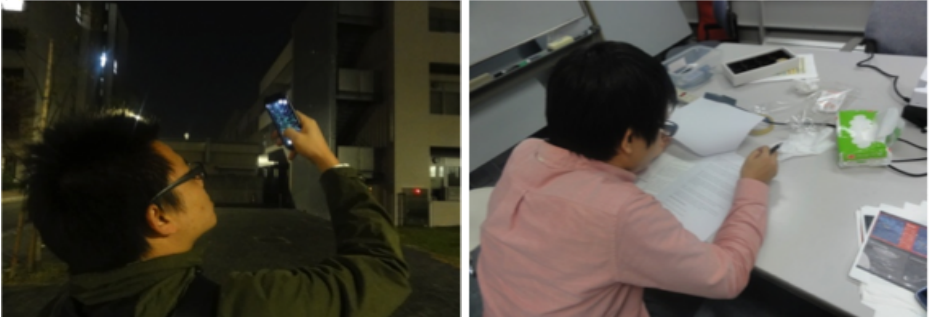
Figure 10. The participant was observing constellations outdoors using the system ( left ); the participant was completing the tasks and answering questionnaires on the R-WOSARLS ( right